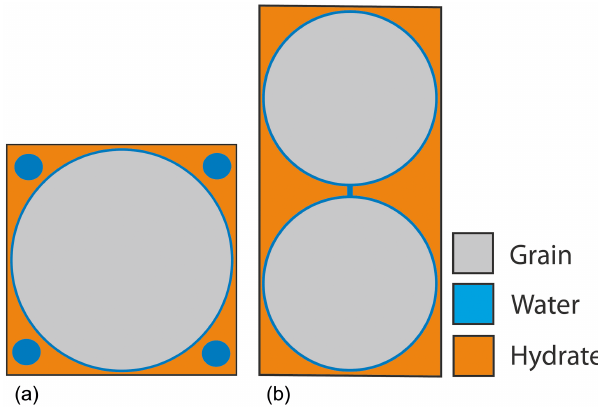
Figure 13. Fundamental blocks of two periodic media representing loose sandstone grains which are separated from the embedding GH background by a thin interfacial water film. In (a) water pockets are located in the GH background and in (b) the interfacial water films are connected to another through a water